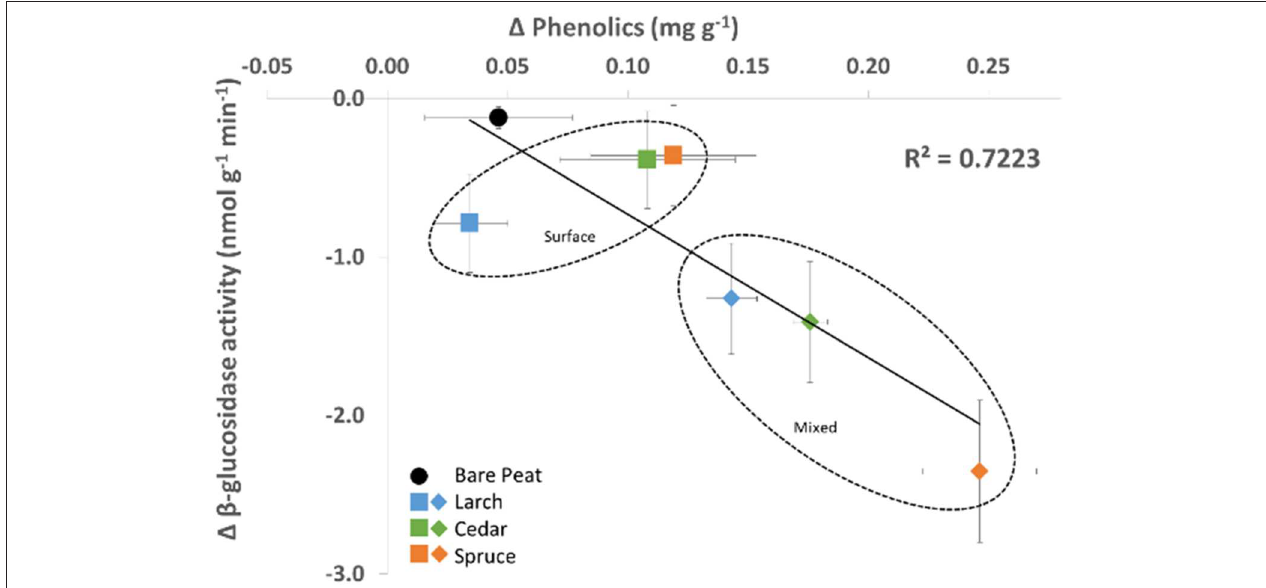
FIGURE 4 | Relationship between mean change in concentration of Phenolics and mean change in β -glucosidase activity over the period September 2013 to July 2014 ( n =